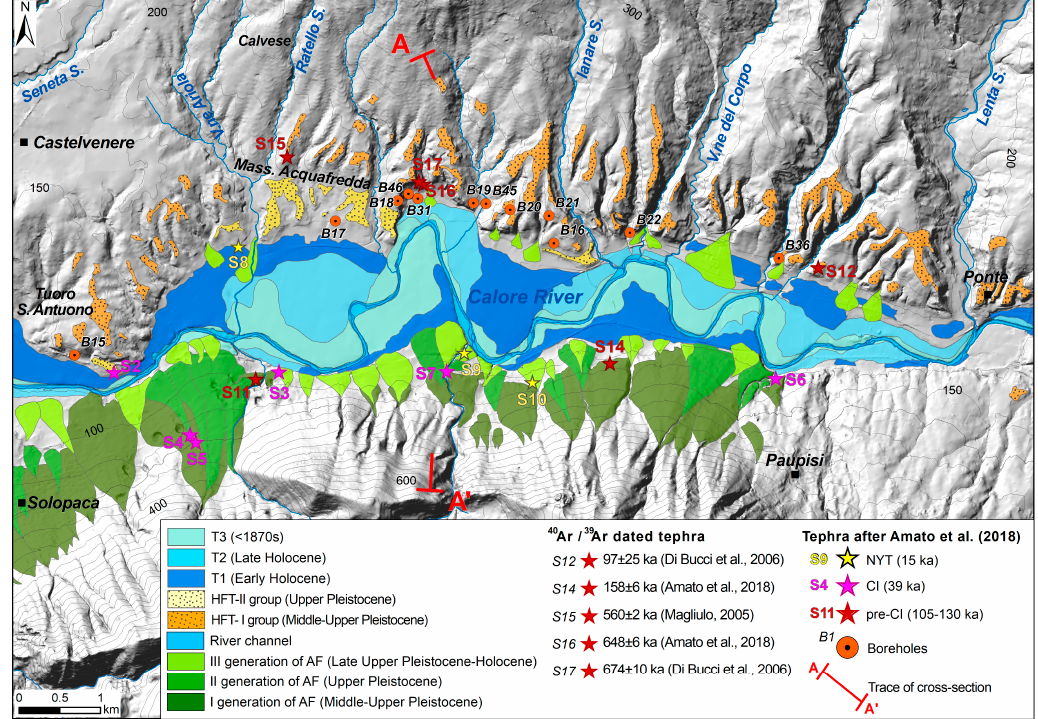
Figure 2. Geomorphological sketch of sector A.